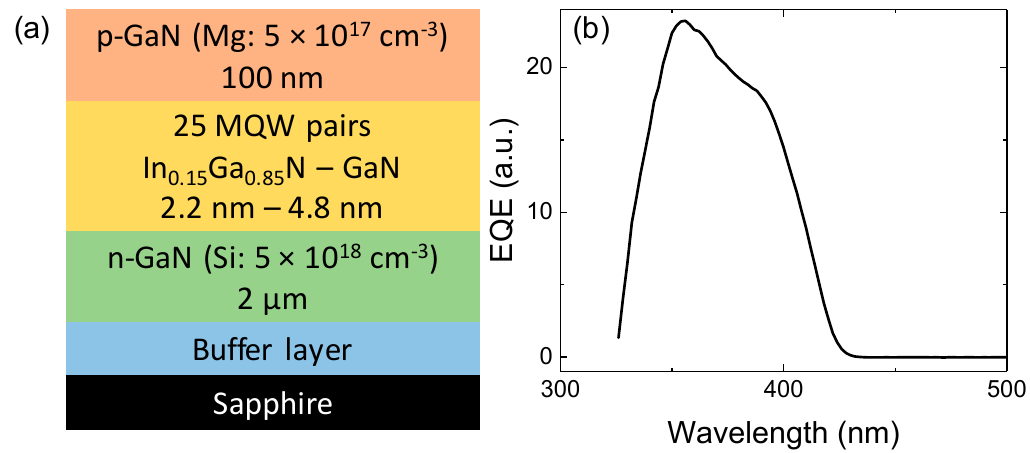
Figure 1. ( a ) Structure of the receiver and ( b ) photocurrent spectrum of a representative sample.